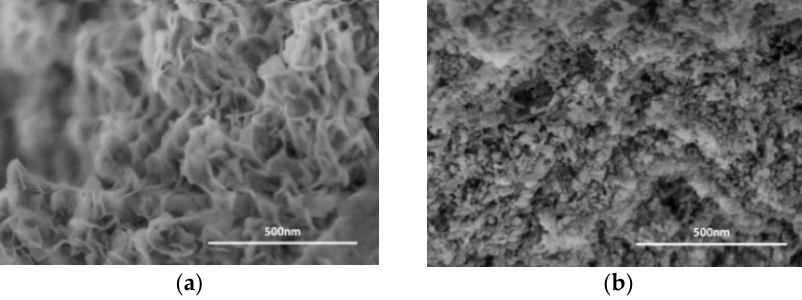
Figure 3. SEM images of ( a ) the Ni/PA catalyst and ( b ) the Ni/Al 2 O 3 catalyst [19]. Reproduced from Ref. [19] with permission from the Royal Society of Chemistry.